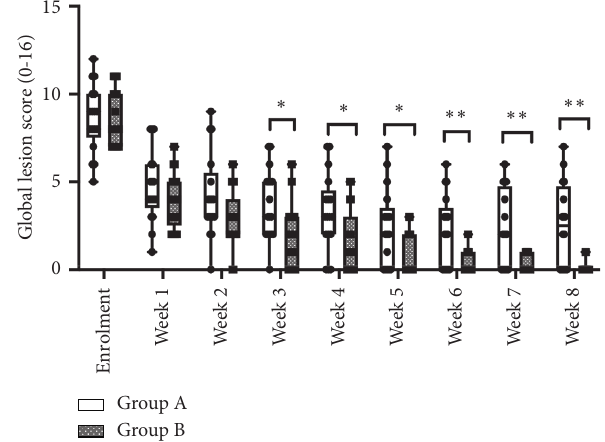
Figure 3: Average global lesion scores by treatment and study week. ∗ p < 0 . 05; ∗∗ p < 0 . 01.